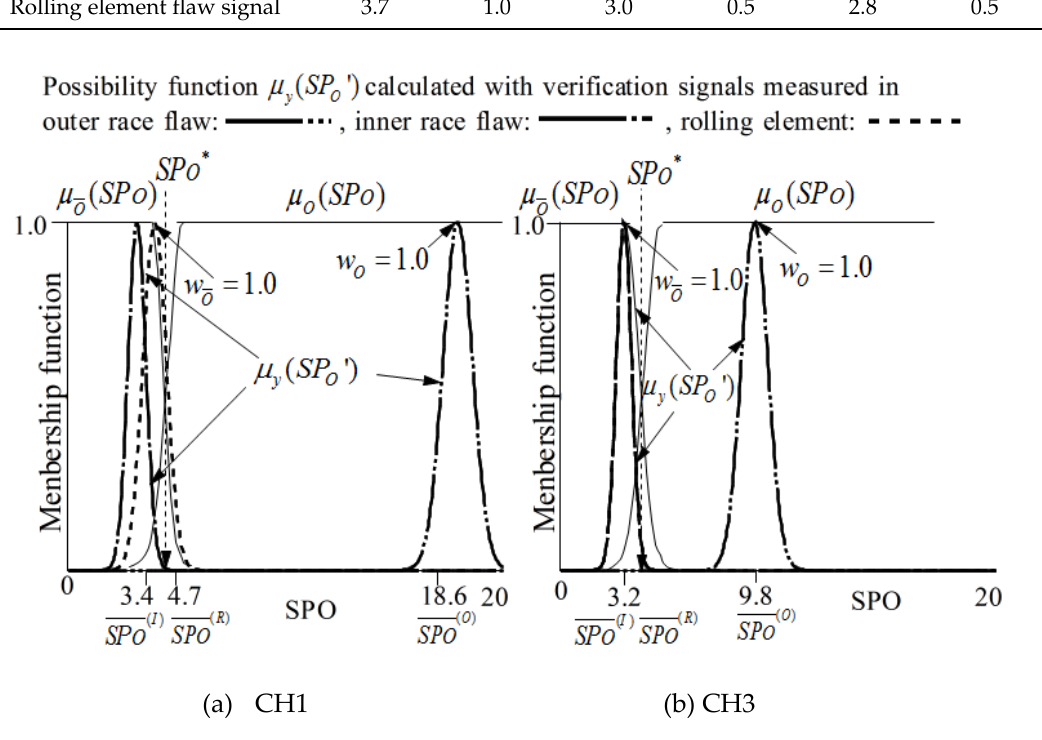
( SP ) , µ ( SP ) , and µ y ( SP O O O O